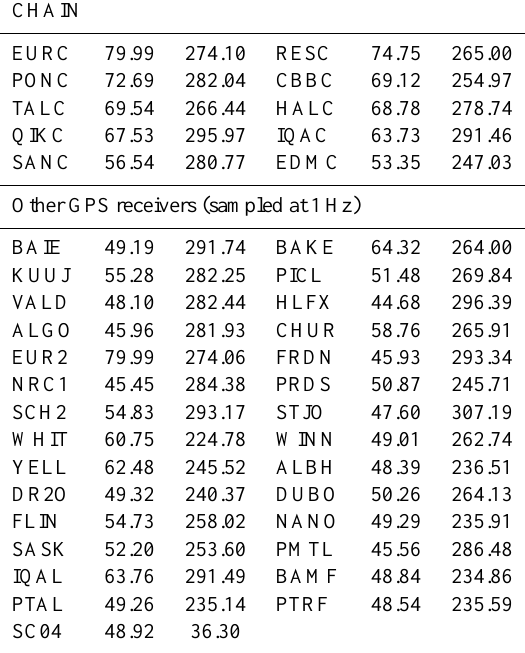
Table 1. Geographic latitudes and longitudes of